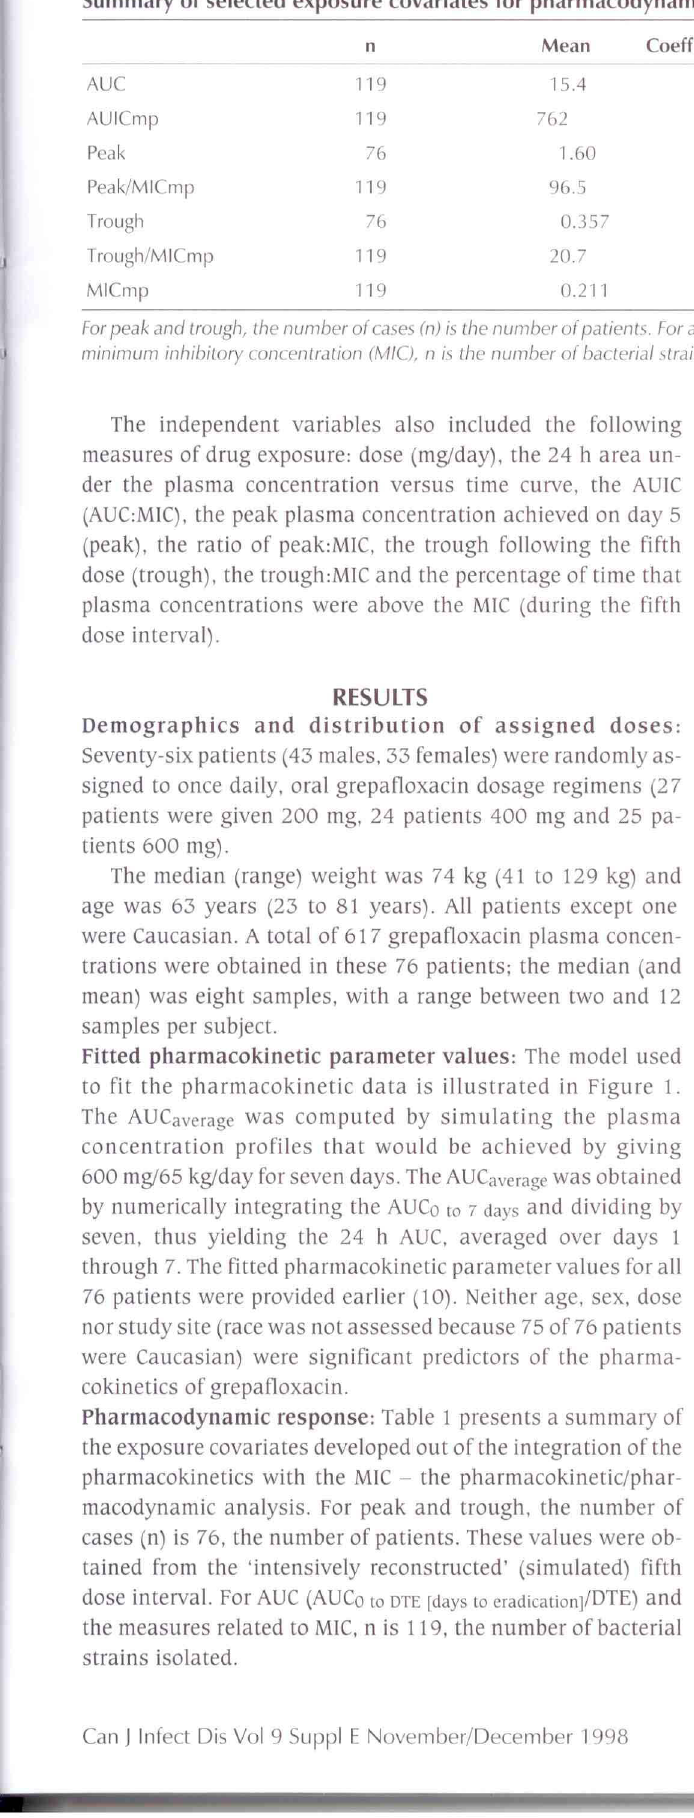
Summary of selected exposure covariates for pharmacodynamic